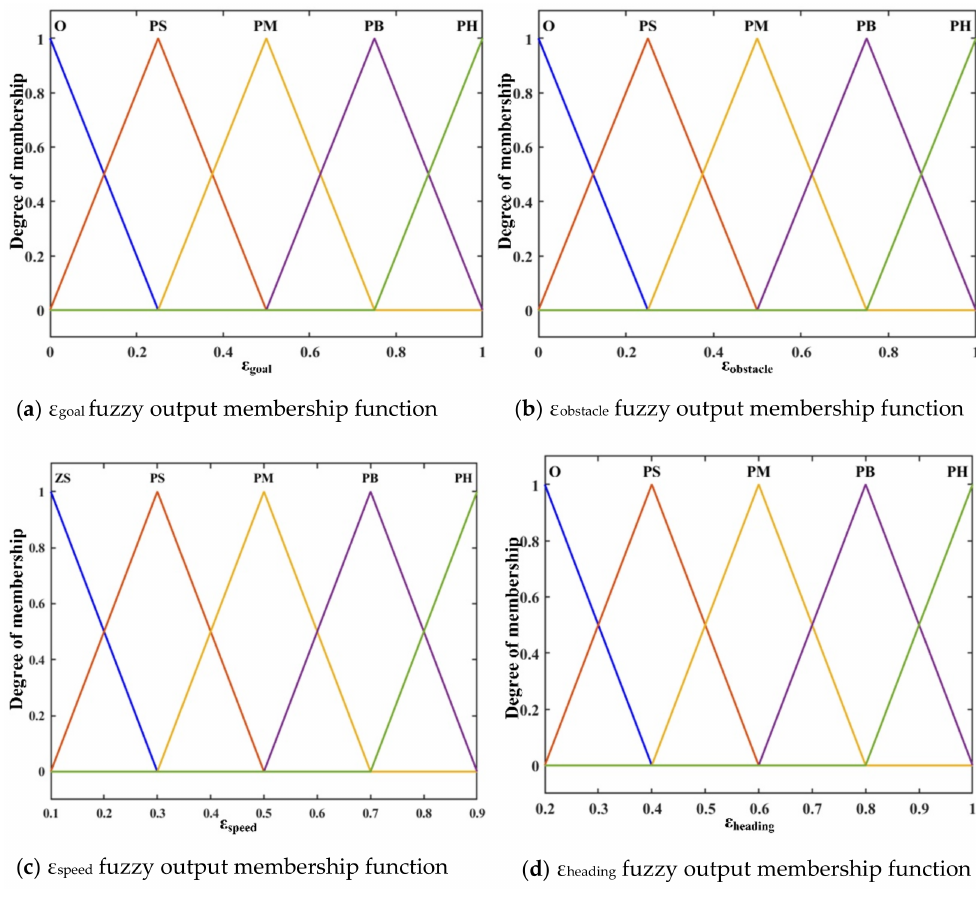
Figure 11. Fuzzy output membership functions. The fuzzy rules Distgoal, Diatobstacle and ε goal , ε obstalce , ε speed , ε heading are shown in Tables